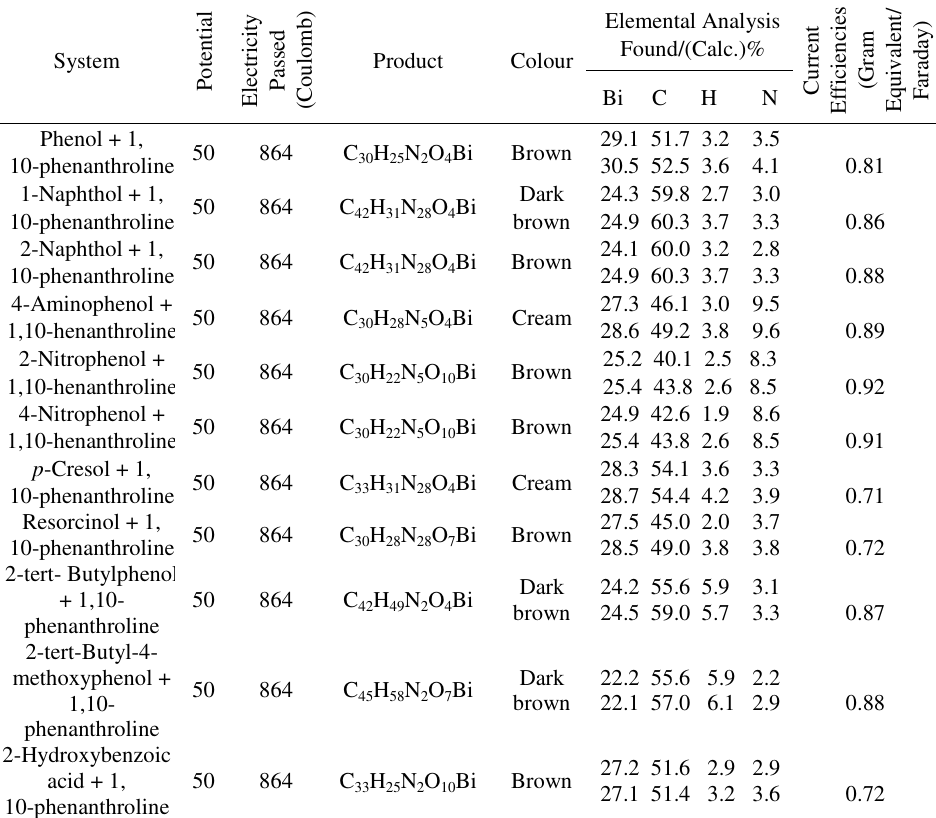
Elemental Analysis Found/(Calc.)%